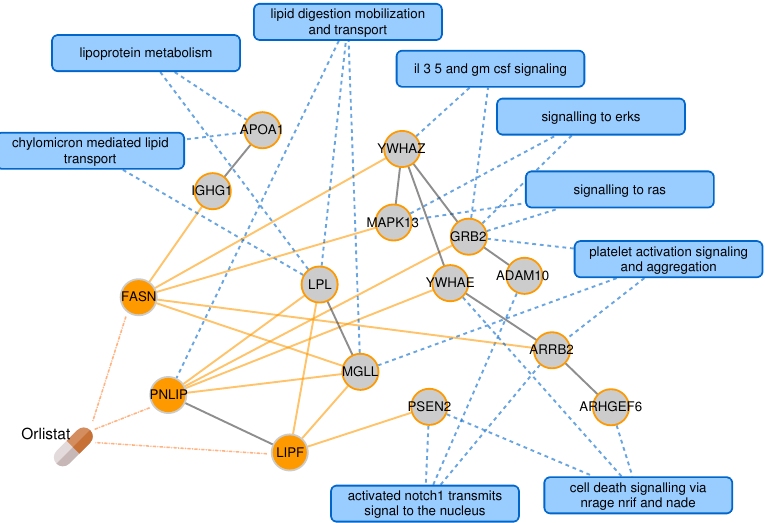
Figure 5. Orlistat from PxEA perspective. The subnetwork shows how the targets of Orlistat are connected to the nearest pathway protein for the pathways shared between T2D and AD. For clarity, only the pathways that are proximal to the drug are shown. Blue rectangles represent pathways, circles represent drug targets (orange) or proteins on the shortest path to the nearest pathway gene (gray). Blue dashed lines denote pathway membership, solid lines are protein interactions. The interactions between the drug and its targets are shown in dashed orange lines and the interactions between the drug targets and their neighbors are highlighted with solid orange